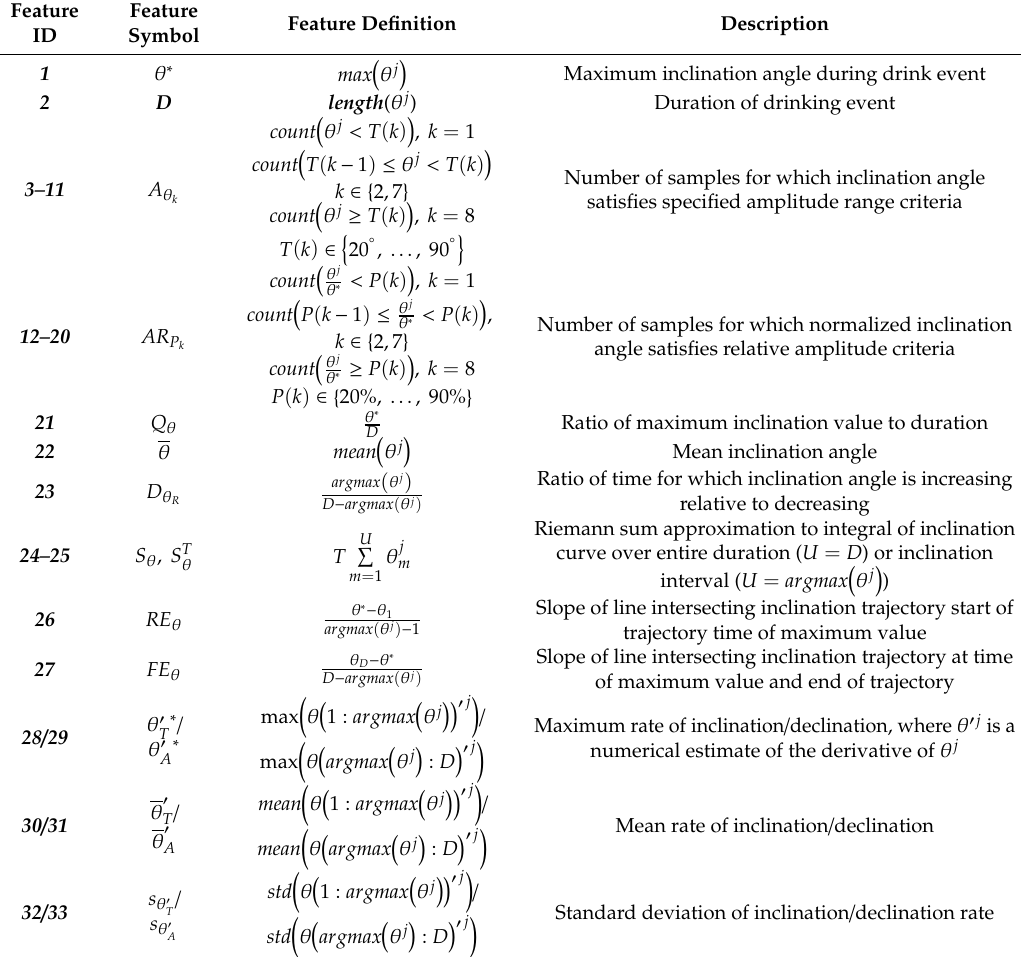
Table A1. Inclination signature (IS) feature